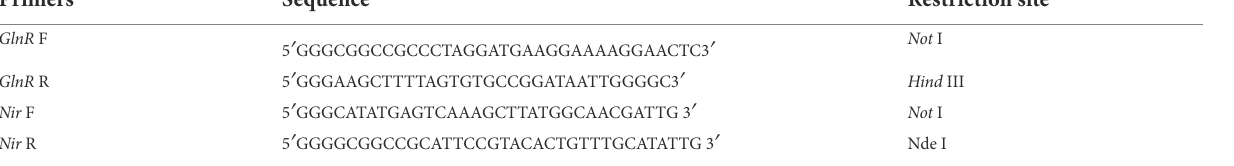
TABLE 1 Primers used in protein expression.